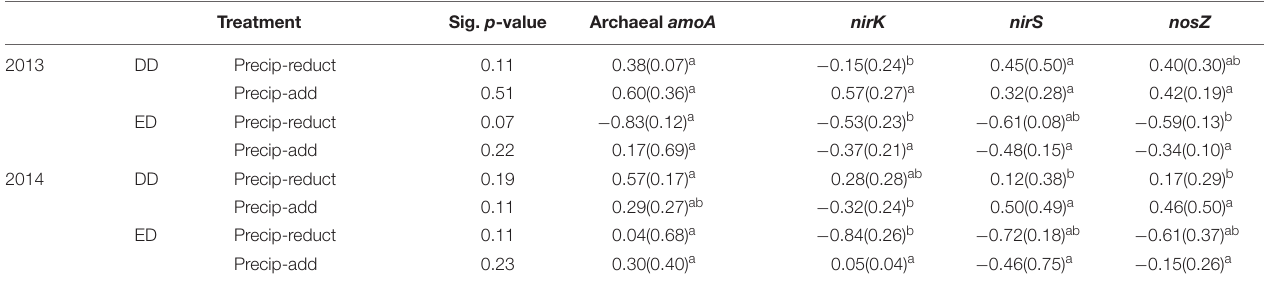
TABLE 1 | Values of the resistance index of functional gene abundances in the DD and ED treatments (means and standard errors, n = 4) in 2013 and 2014, respectively. Treatment Sig. p -value